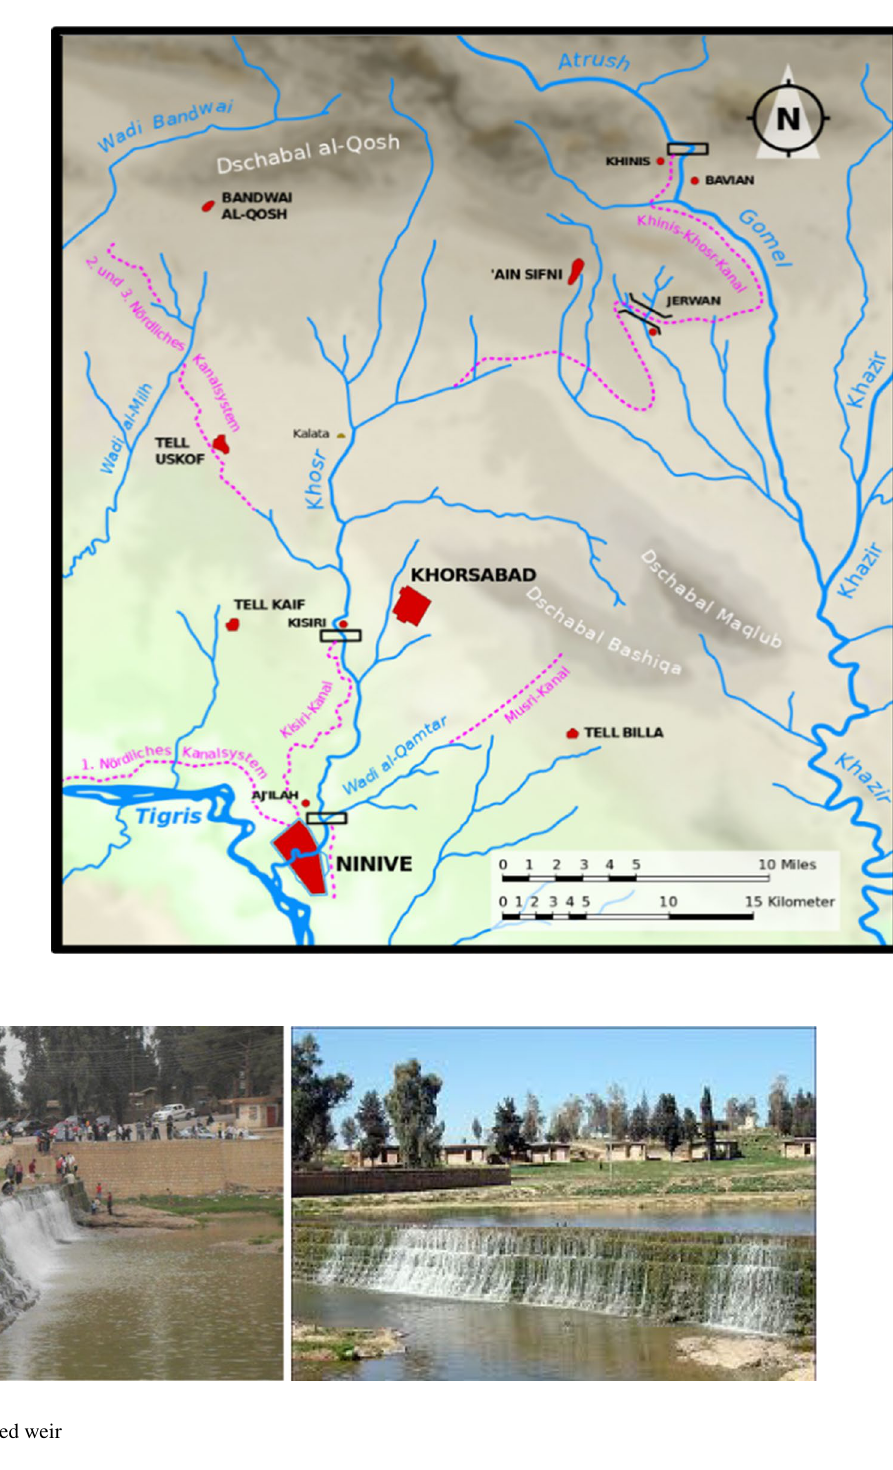
Fig. 1 The location of AL-